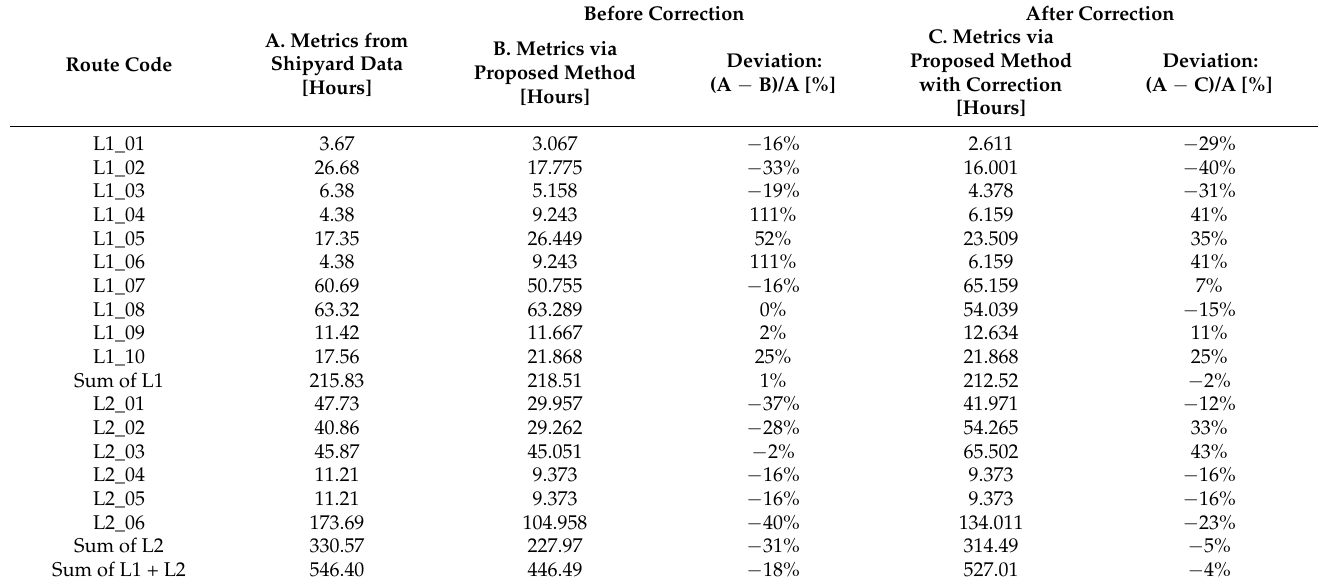
Table 7. Comparison of production metrics before and after correction